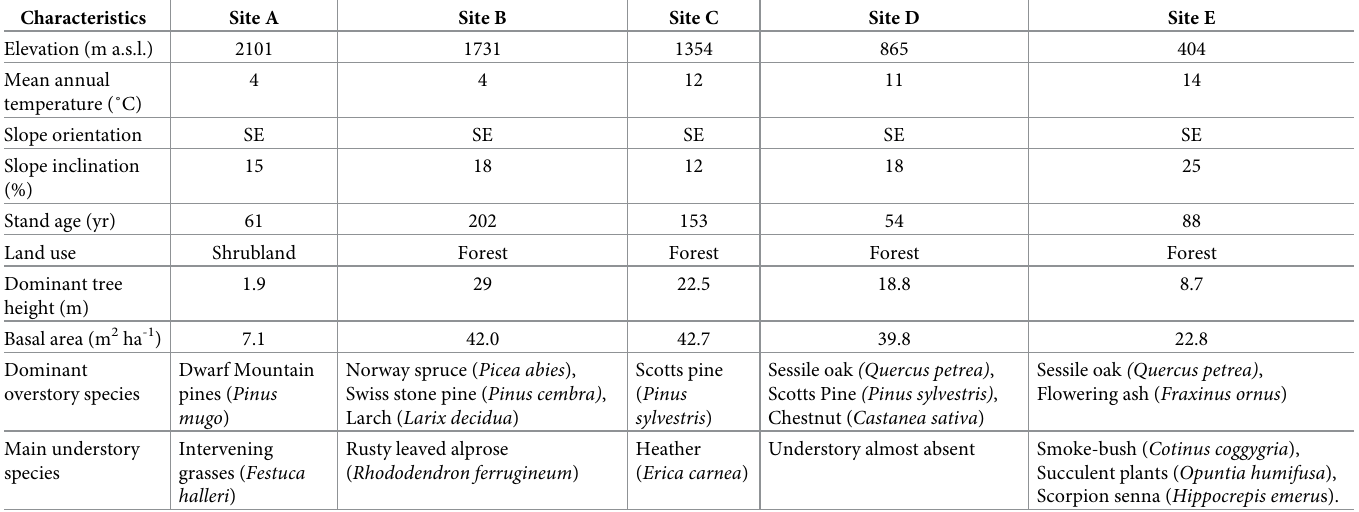
Table 1. General characteristics of the study sites.